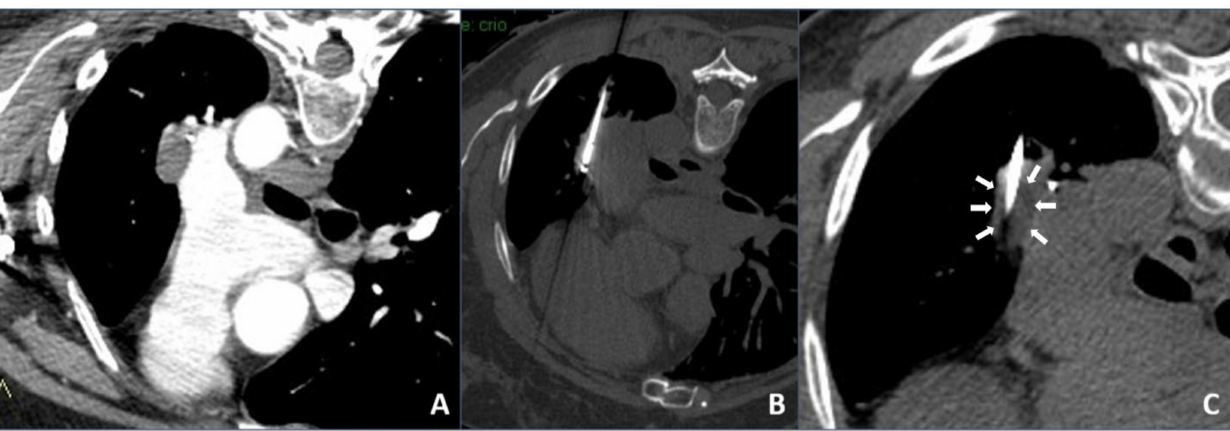
Figure 2. Cryoablation procedure: ( A ) contrast-enhanced axial CT scan showing a left hilum neoplastic lesion adjacent to the left pulmonary artery; ( B ) intra-procedural unenhanced axial CT scan with maximum intensity projection (MIP) reconstruction showing the cryoablation needle inside the lesion; ( C ) intra-procedural unenhanced axial CT scan with MIP reconstruction showing direct visualization of the hypodense core necrotic